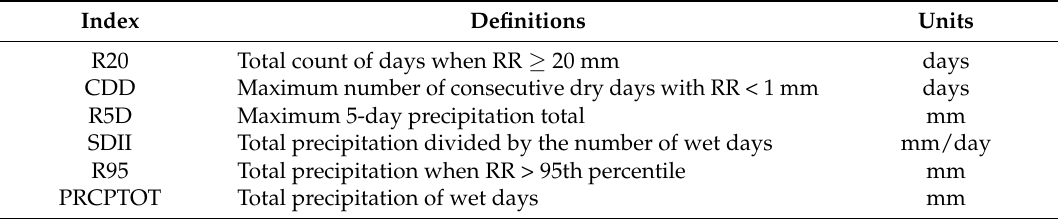
Table 1. Six indices of precipitation extremes as described by Frich et al. [38] 1